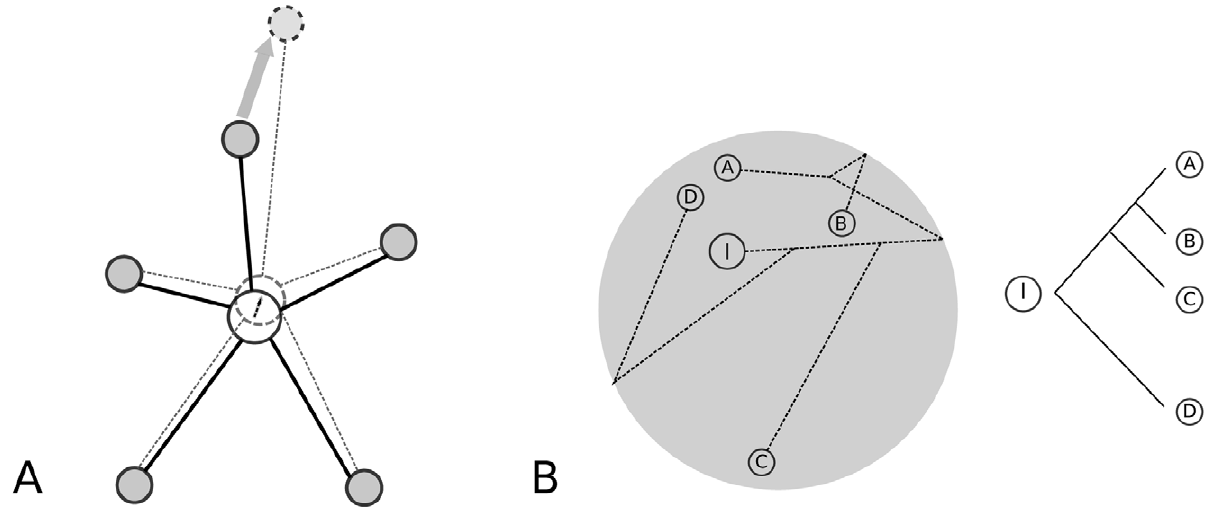
Figure 5. Models of CRM evolution with changes in fitness optimum. (A) The central node represents the CRM of interest and is connected to many interacting partners. With increasing number of connecting partners, we expect the CRM function to change more frequently in small steps but at the same time to be more constrained in function space. (B) A hypothetical evolutionary trajectory in CRM function space. Small changes in a system under global constraints result in non-linear functional evolution with time. The circle represents permissible space within which CRM function can change without causing strong pleiotropic effects. Depicted on the right is the species phylogeny. Starting from I, the ancestor of the existing species, the CRM function moves in the constrained region and generates a non-clock like evolution pattern in the extant species–species A and D are most distantly related phylogenetically but most similar functionally.